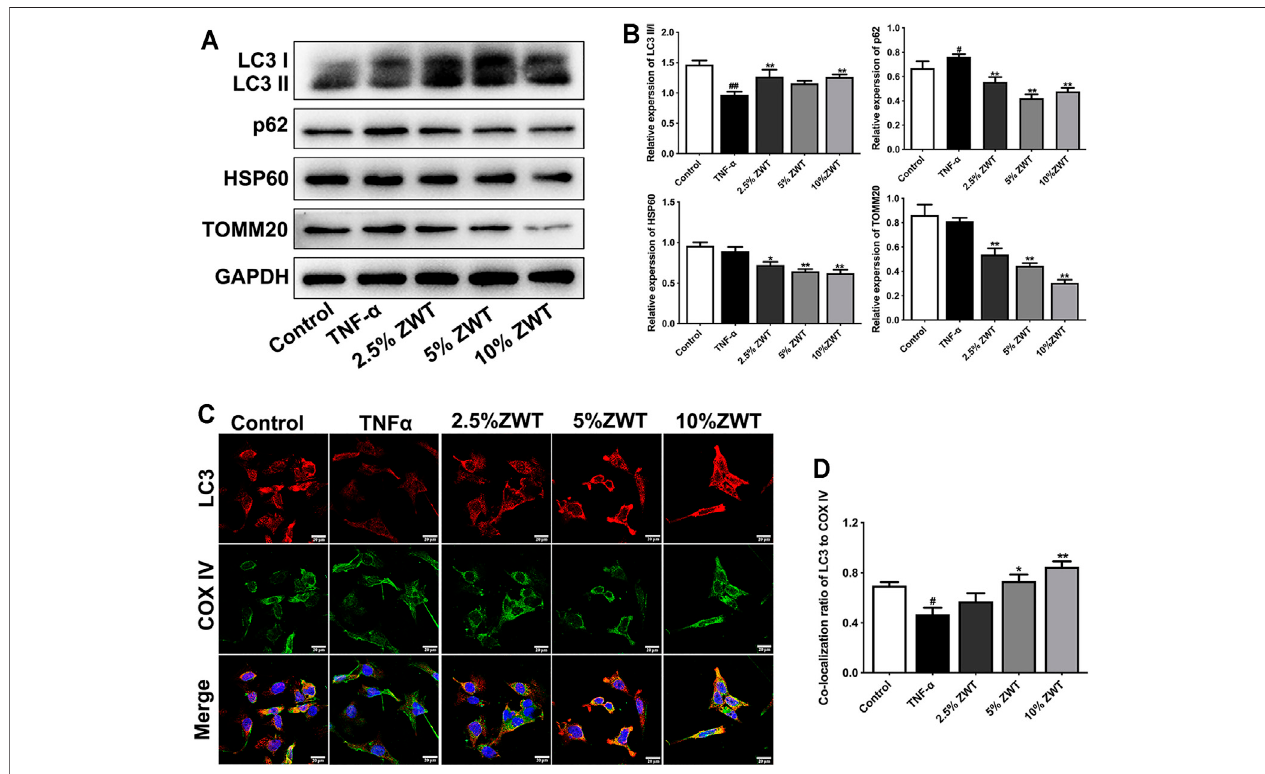
FIGURE6| ZWTpromotedmitophagy inpodocytes. (A,B) TheproteinblotsandquantitativeanalysisofLC3II/I,p62,HSP60,andTOMM20.Theobtainedvalues ofHSP60,TOMM20,andp62werenormalizedtoGAPDH;LC3IIvalueswerenormalizedtoLC3I. (C,D) TherepresentativeimagesandquantitativeanalysisofLC3and COXIV colocalization ( × 400,scalebar (cid:2) 20 μ m).Dataarerepresentedasmean ± SD ( n (cid:2) 3). # p < 0.05, ## p < 0.01versuscontrolgroup, * p < 0.05 and ** p < 0.01versus TNF- α